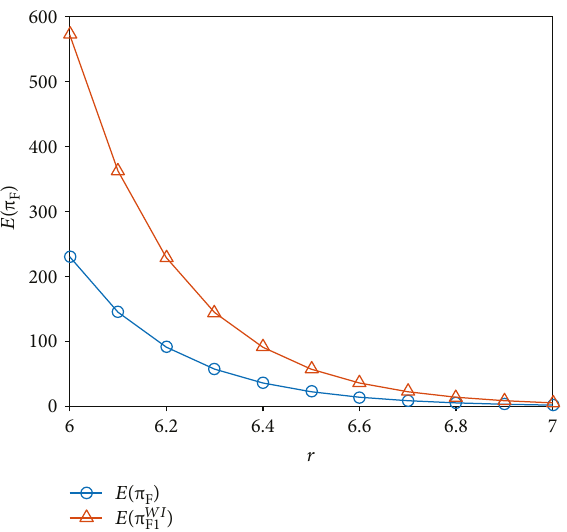
Figure 5: Change of farmer ’ s performance before and after the implementation of WI , φ .